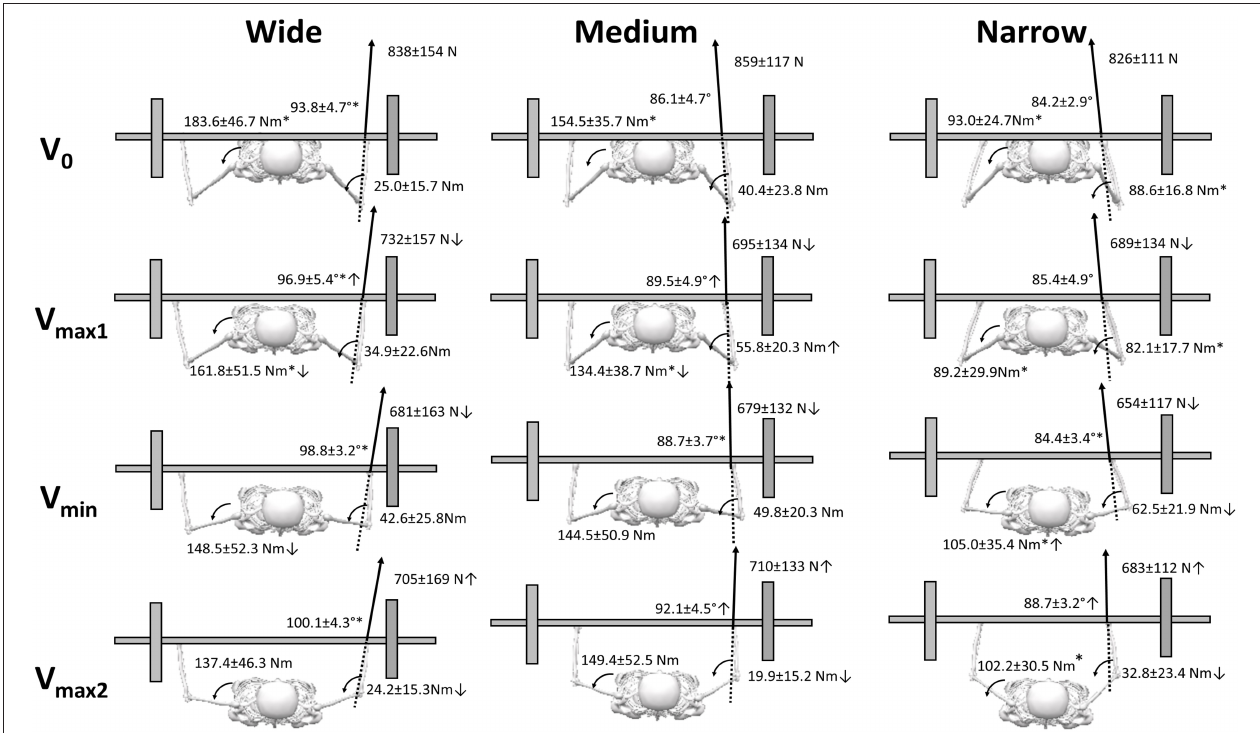
FIGURE 5 | Resultant force, direction of the resultant force vector in the transversal plane, and moment around elbow and shoulder during the events V 0 , v min , v max2 , v 0, and v max1 for the wide, medium, and narrow grip bench press conditions. *Indicates a significant difference when compared with the other two grip widths. † Indicates a significant difference with all other events for this grip width. → Indicates a significant difference between the two specified events for this grip